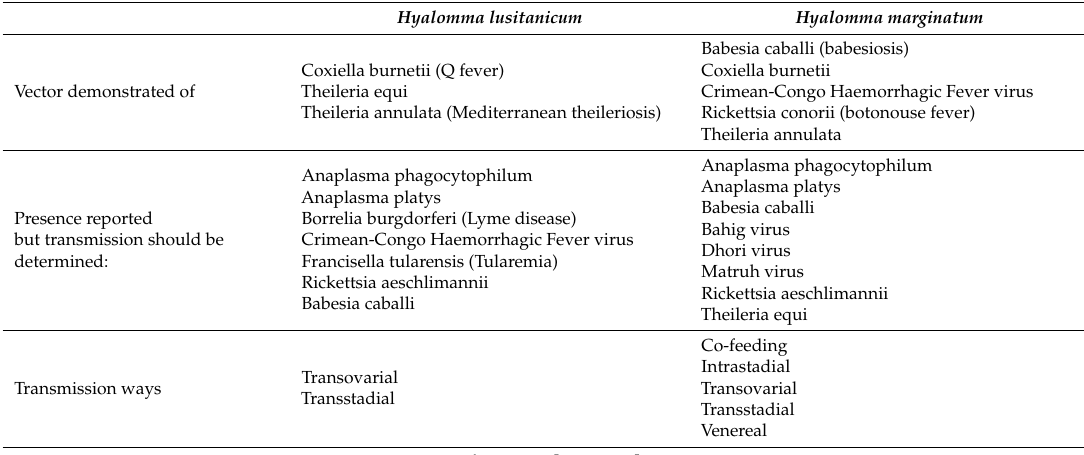
Table 1. Known vectorial data of Hyalomma lusitanicum and Hyalomma marginatum